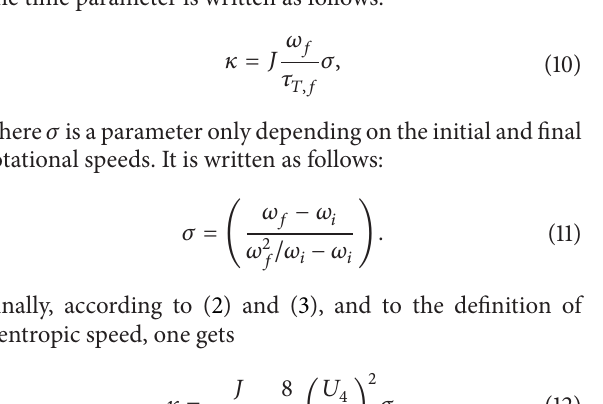
Figure 2: Transient response of the stage depending on the position of “ i ” and “ f ” in the map for the same rotational speed jump Δ𝜔